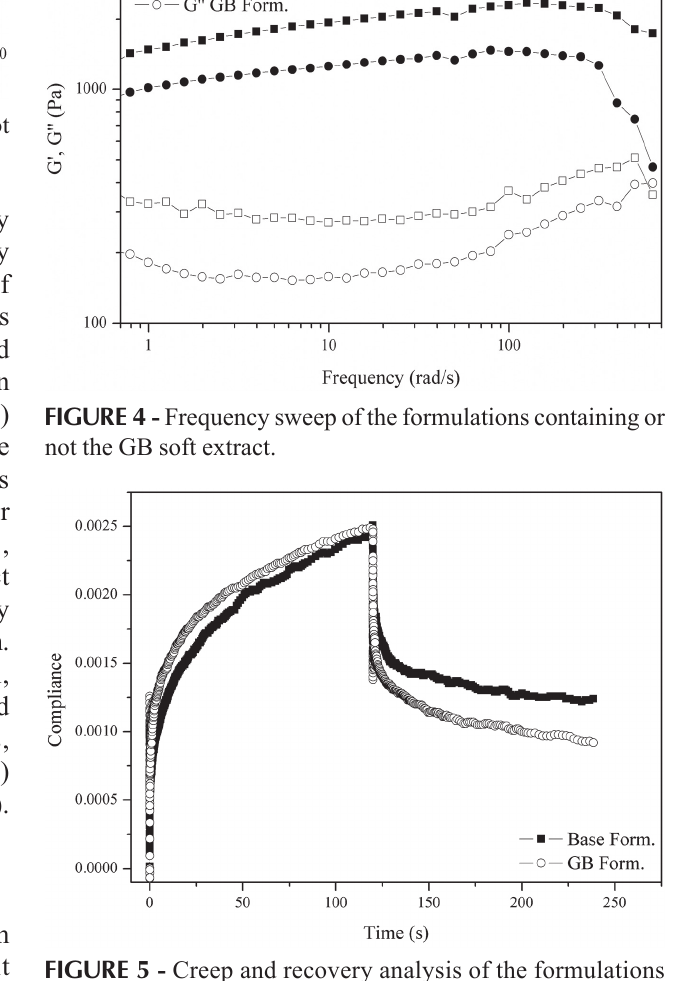
FIGURE 5 - Creep and recovery analysis of the formulations containing or not the GB soft